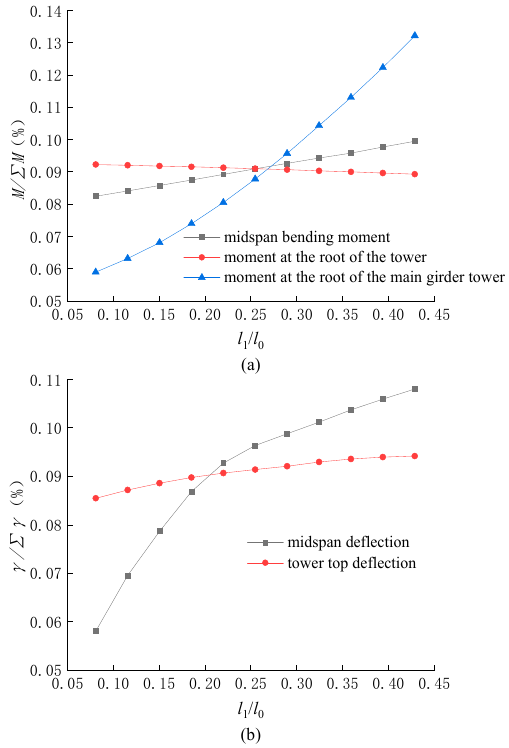
Figure 8. In fl uence of the length of the cable-free zone in the span on internal force and deformation of the structure. ( a ) moment ; ( b ) de fl ection. Note: M/ ∑ M (%), γ / ∑γ (%) have the same meaning as